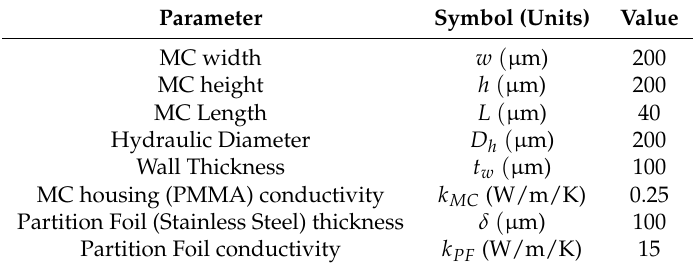
Table 1. µ Hx geometry used for simulations.